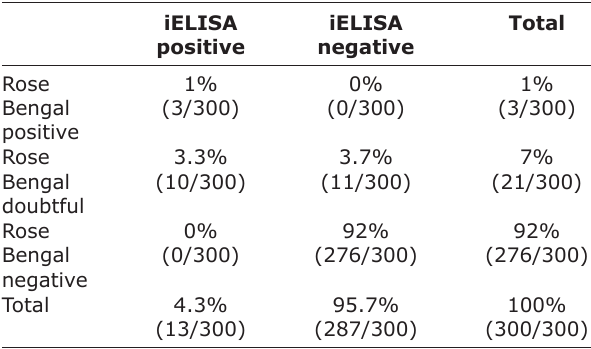
Table-2: Test result for brucellosis on 300 serums of goats collected in the Province of Bam in Burkina Faso, 2021.